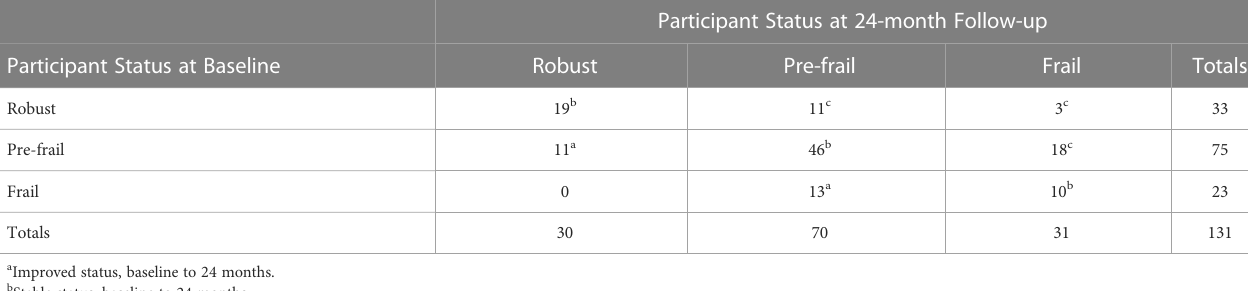
TABLE 3 Frailty status of study participants at 24-months in relation to their frailty status at